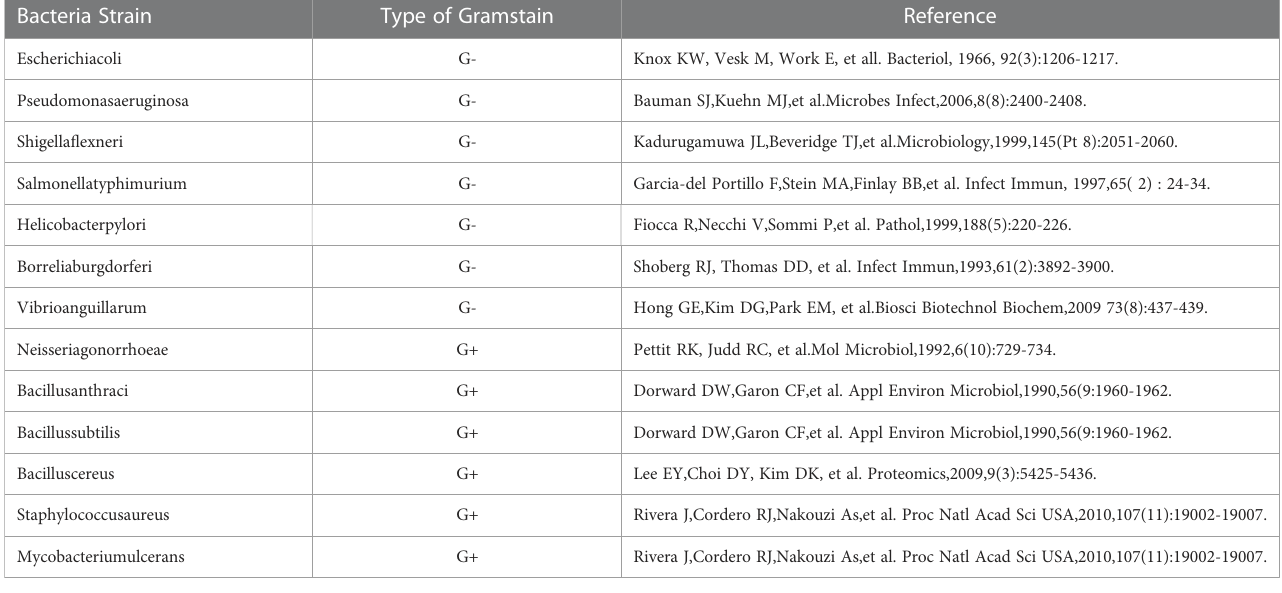
TABLE 1 Bacteria reported to be able to produce OMVs.